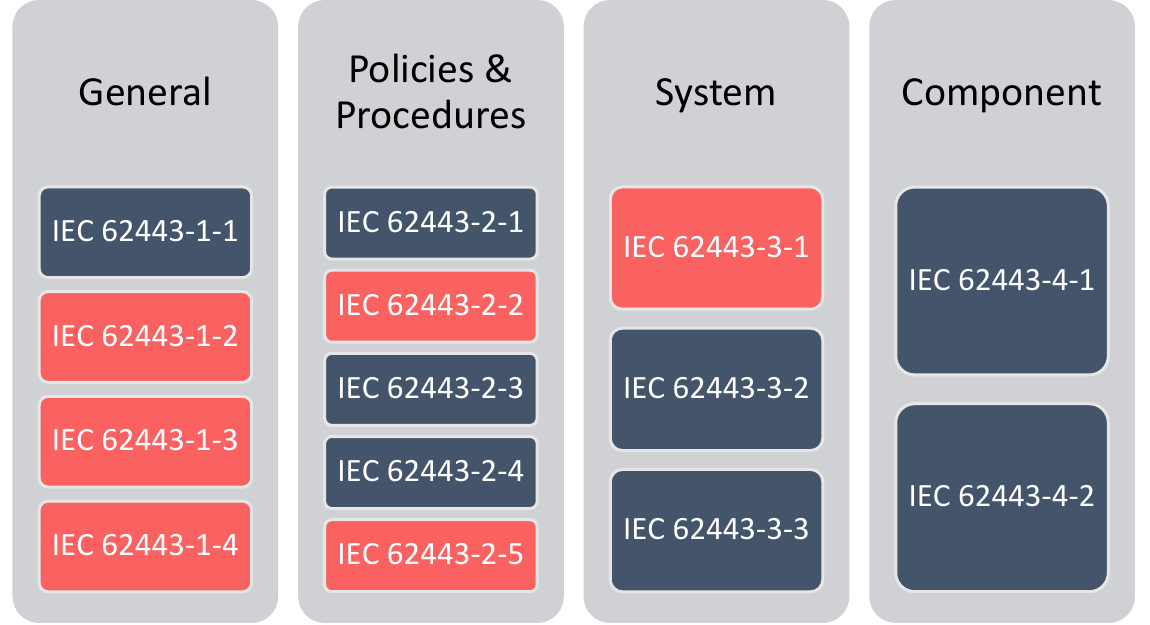
Figure 12. Current status of completion ISA/IEC 62443.